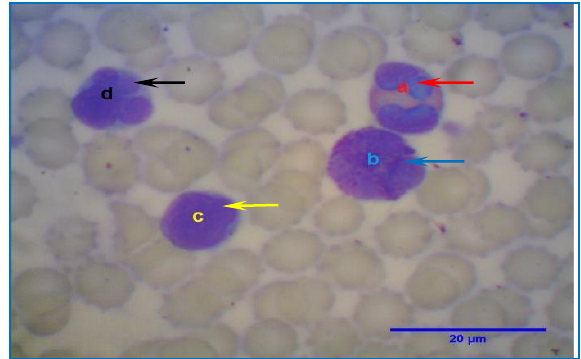
Figure, 1: (a) Female mature neutrophil with sex chromatin, (b) Central Pallor of RBC giemsa stain, (100 x × 1.3 megapixels).